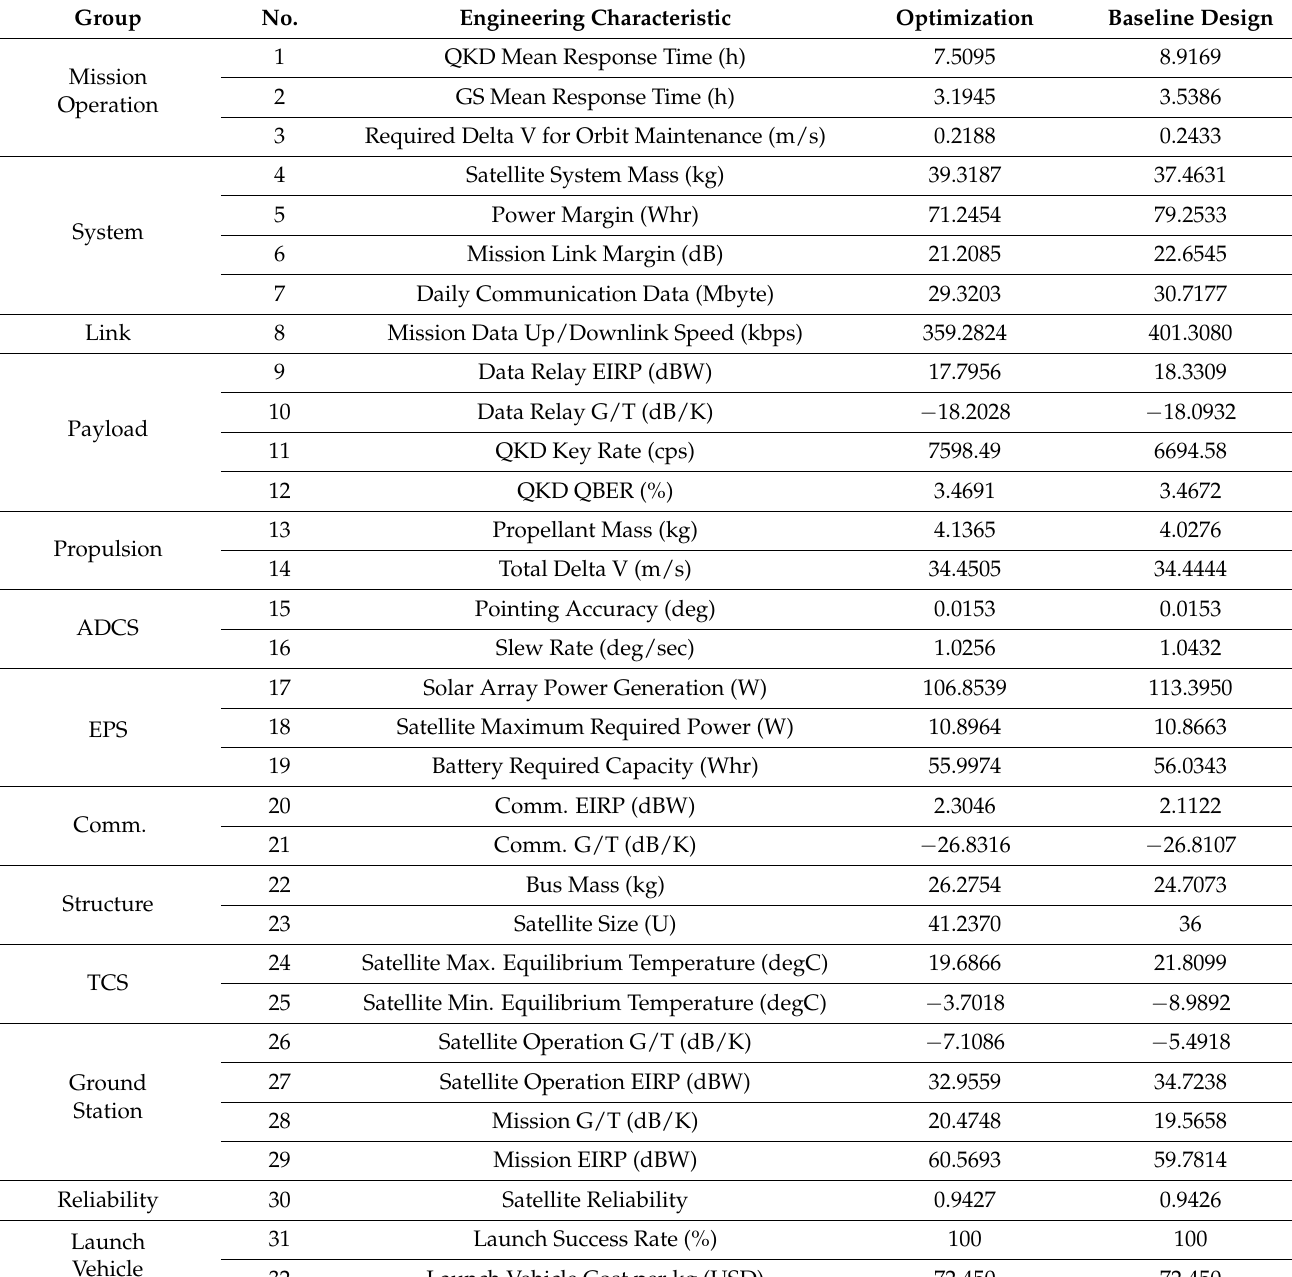
Table 12. Engineering characteristics of the final baseline